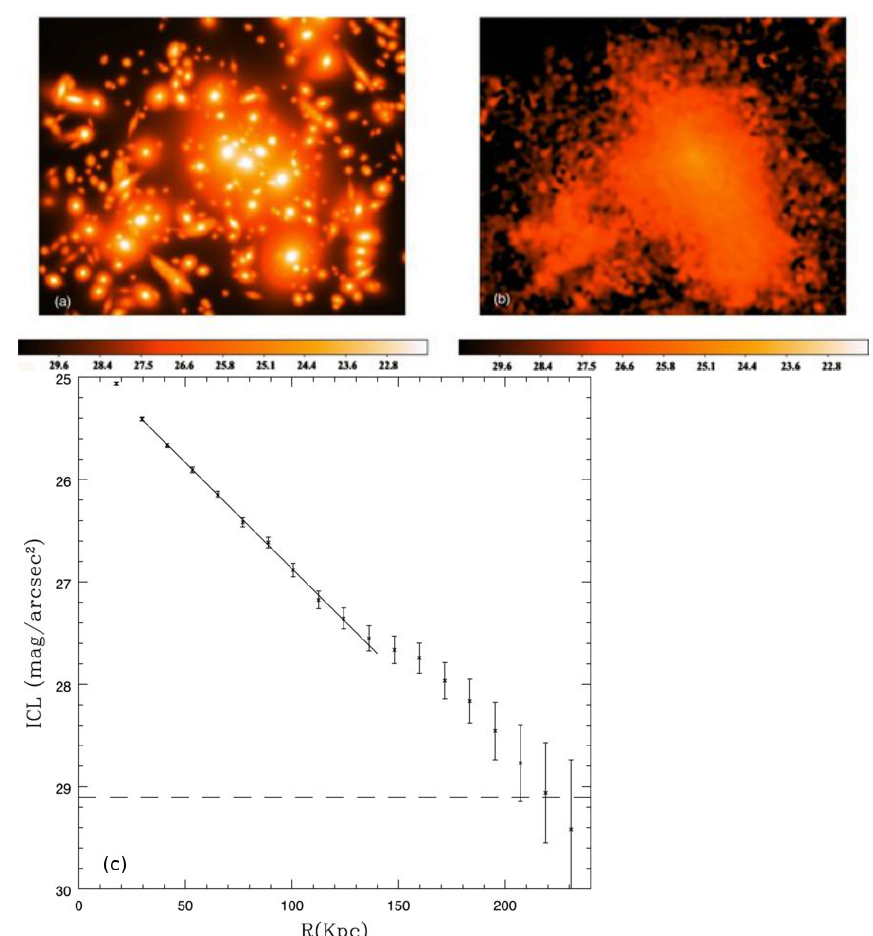
Figure 6. The LBT image of the central ( R ∼ 200 kpc) galaxy cluster CL0024+17, z ∼ 0.4, the field size is 95 × 77 arcsec 2 . ( a ) the apparent overlapping diffuse light from galaxies and around them; ( b ) only residual background ICL after substraction of ( a ) from the original image is shown; ( c ) the inferred ICL radial profile is centered at its maximum and extends up to > ∼ 200 kpc, error bars indicate uncertainties connected partly with background subtraction from [156], their Figures 6 and 7. Reproduced with permission from E. Giallongo et al., published by AAS (ApJ)